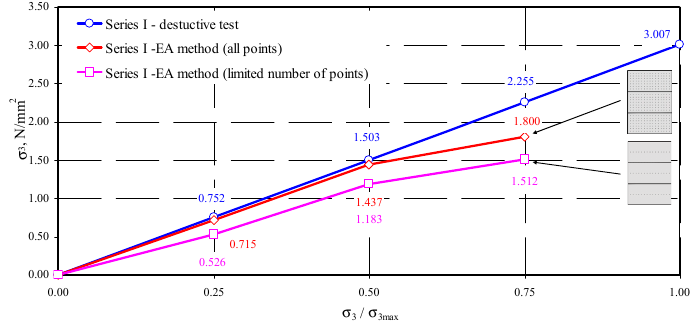
Materials 2020 , 13 , 2852 Figure 14. Measurement results of stress in the model I-1. Figure 14. Measurement results of stress in the model I-1.